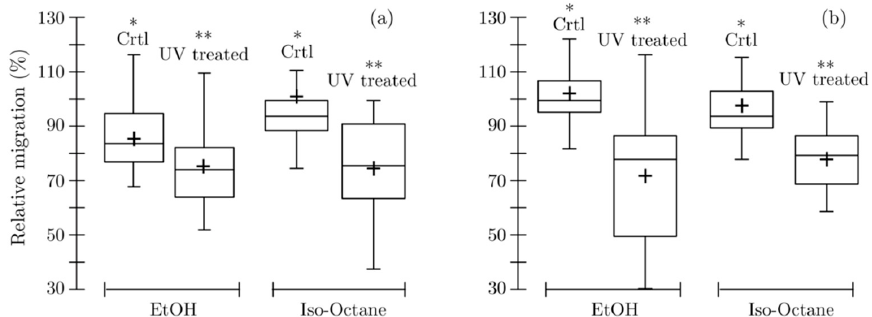
Figure 6. Univariate plot summarizing the distribution of relative migration values as a function of aging treatment applied to neat and nanocomposite PBSA ( a ) and PHBV ( b ) materials in contact with 95% ethanol and isooctane.